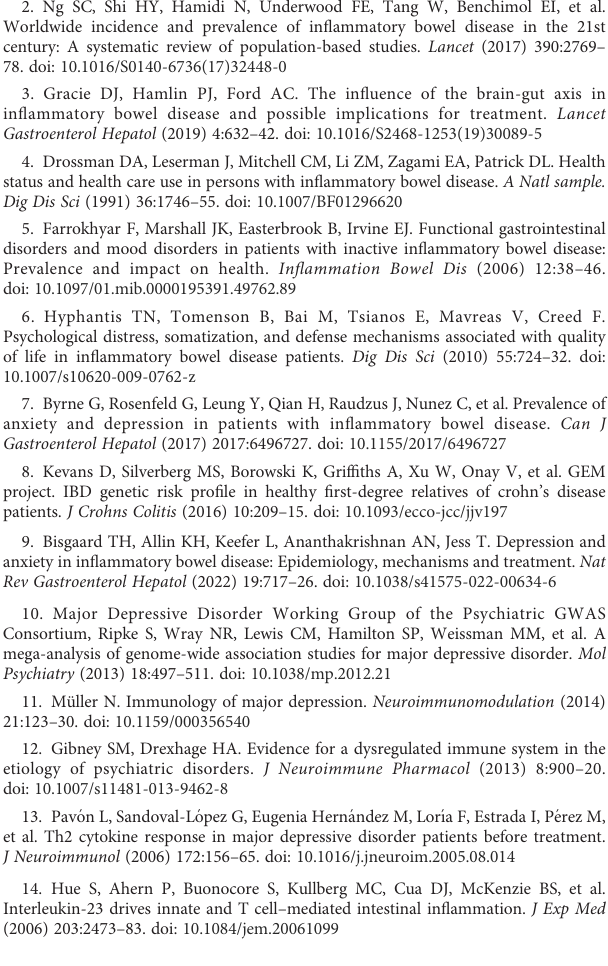
curated from MSigDB in distinct molecular subtypes. (C) The relationship between cophenetic, dispersion, residuals, and silhouette coef fi cients with respect to the number of clusters. (D) Heatmap representation of NMF clustering for 33 core genes in the meta-GEO cohort with cluster numbers from 2 to 10. SUPPLEMENTARY FIGURE 2 Depression-related molecular subtypes characterized by distinct immune and metabolism landscapes (A) Heatmap of the correlation between 33 core genes and 22 immune in fi ltrating cells. (B) The expression levels of depression-related factors between the two subtypes. The asterisks represented the statistical P-value (*P < 0.05; **P < 0.01; ***P < 0.001; ****P < 0.0001). SUPPLEMENTARY FIGURE 3 Unsupervised clustering of 263 most representative depression phenotype- related signature genes in the IBD cohort. (A) Functional annotation for 263 mostrepresentativedepression phenotype-related signature genesusing GO enrichment analysis. (B) The relationship between cophenetic, dispersion, residuals, and silhouette coef fi cients with respect to the number of clusters. (C) Heatmap representation of NMF clustering for 263 most representative depression phenotype-related signature genes in meta-GEO with cluster numbers from 2 to